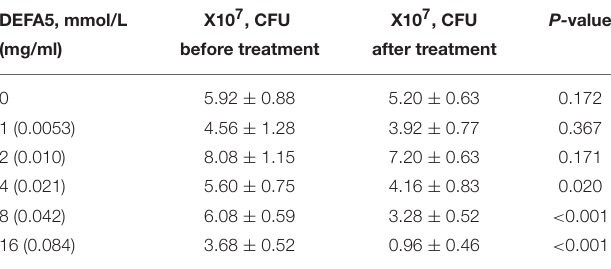
TABLE 5 | DEFA5 inhibits Helicobacter hepaticus in vitro . DEFA5, mmol/L X10 7 , CFU P- value (mg/ml) before treatment after